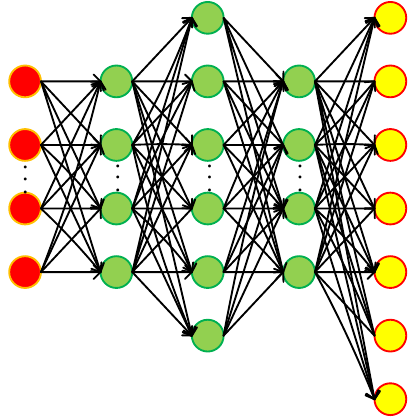
Figure 6. The structure of fully-connected layer